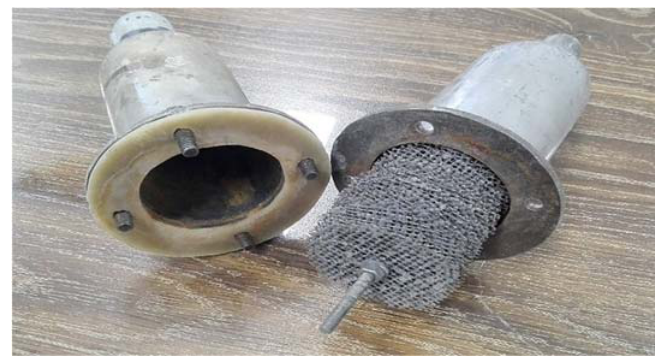
Figure 16. Coated wire meshes arrangement